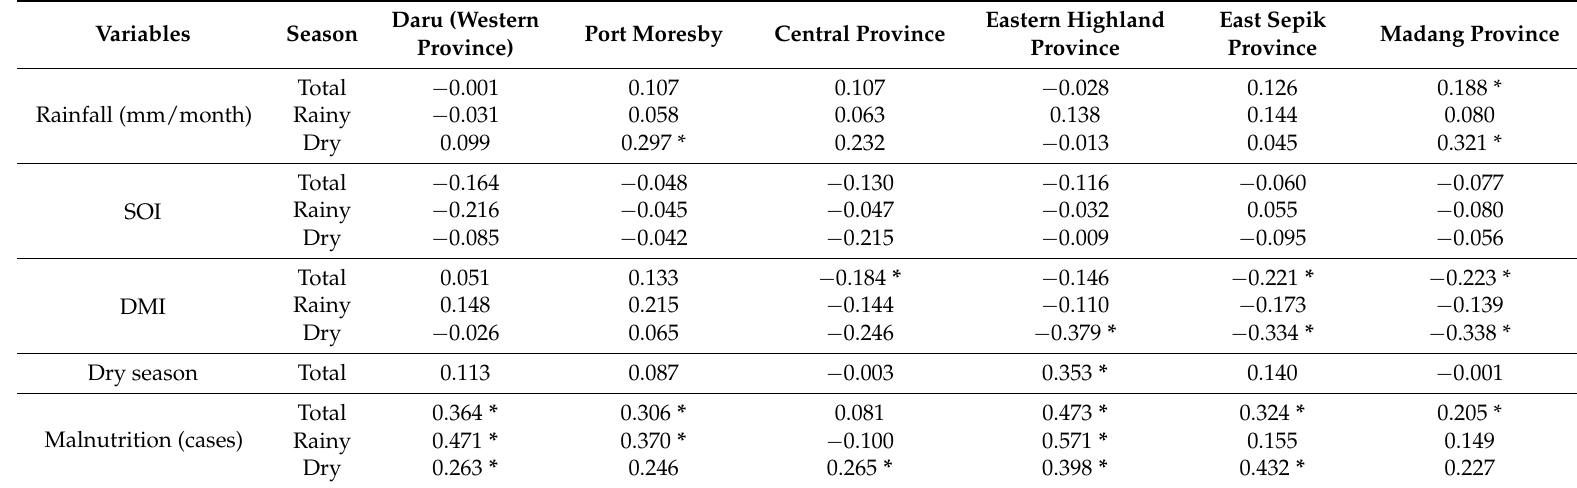
Table 2. Spearman correlation coefficients for independent variables of climate, malnutrition cases and childhood pneumonia cases under five years of age in six regions in Papua New Guinea between